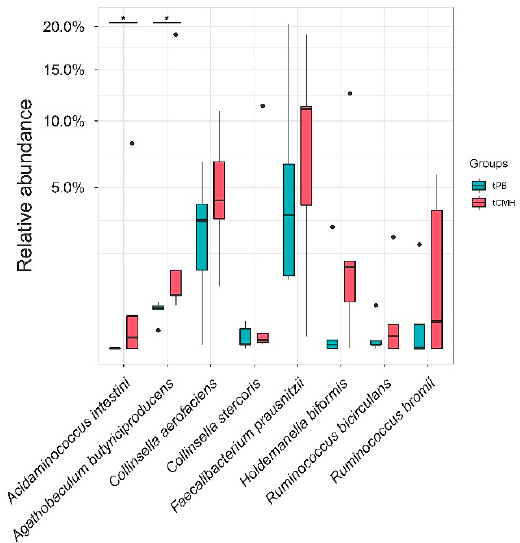
Figure 3. Taxonomic profiles of gut microbiome using WMGS datasets. ( A , B ) Boxplot of relative abundance of microbial phyla across baselines and treatments, respectively. ( C , D ) Stacked column graph showing the relative abundance of taxonomic families across baselines and treatments, respectively. In addition, bPB, bCMH, tPB, and tCMH represent baseline placebo, baseline CMH, treatment with placebo, and treatment with CMH, respectively.